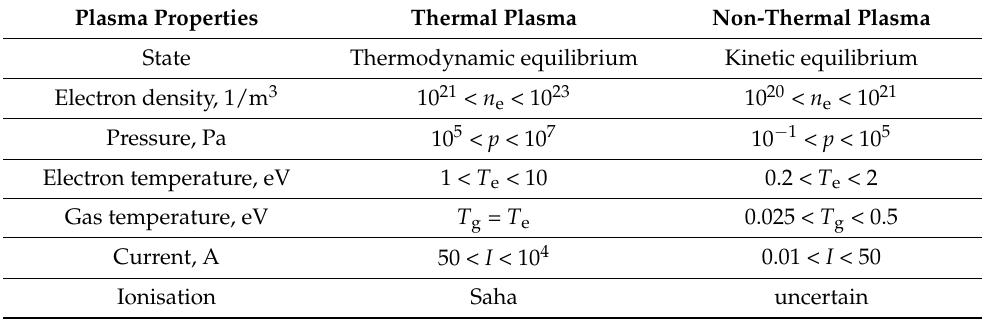
Table 1. Comparison of thermal and non-thermal plasma properties